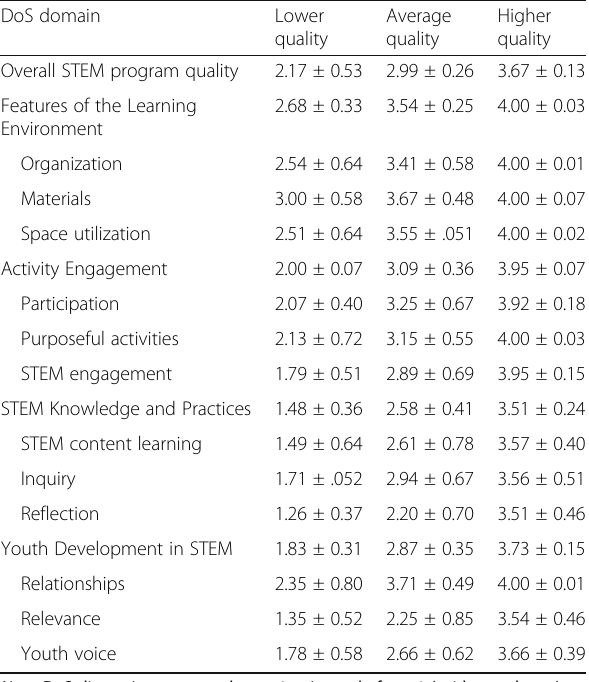
Table 5 Mean (± SD) DoS ratings for STEM-focused afterschool programs that equated to lower, average, or higher levels of STEM program quality by domain and by